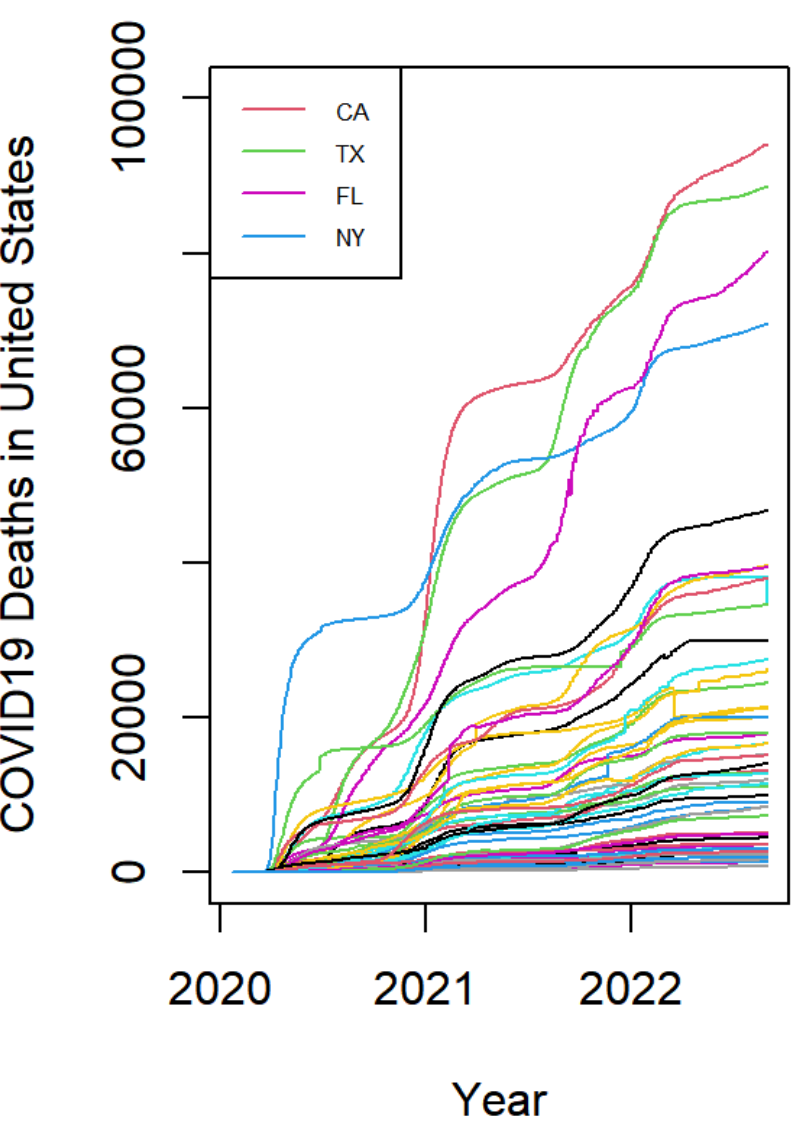
Figure 1. COVID-19 daily cumulative mortality data for 50 states and Washington, D.C. (22